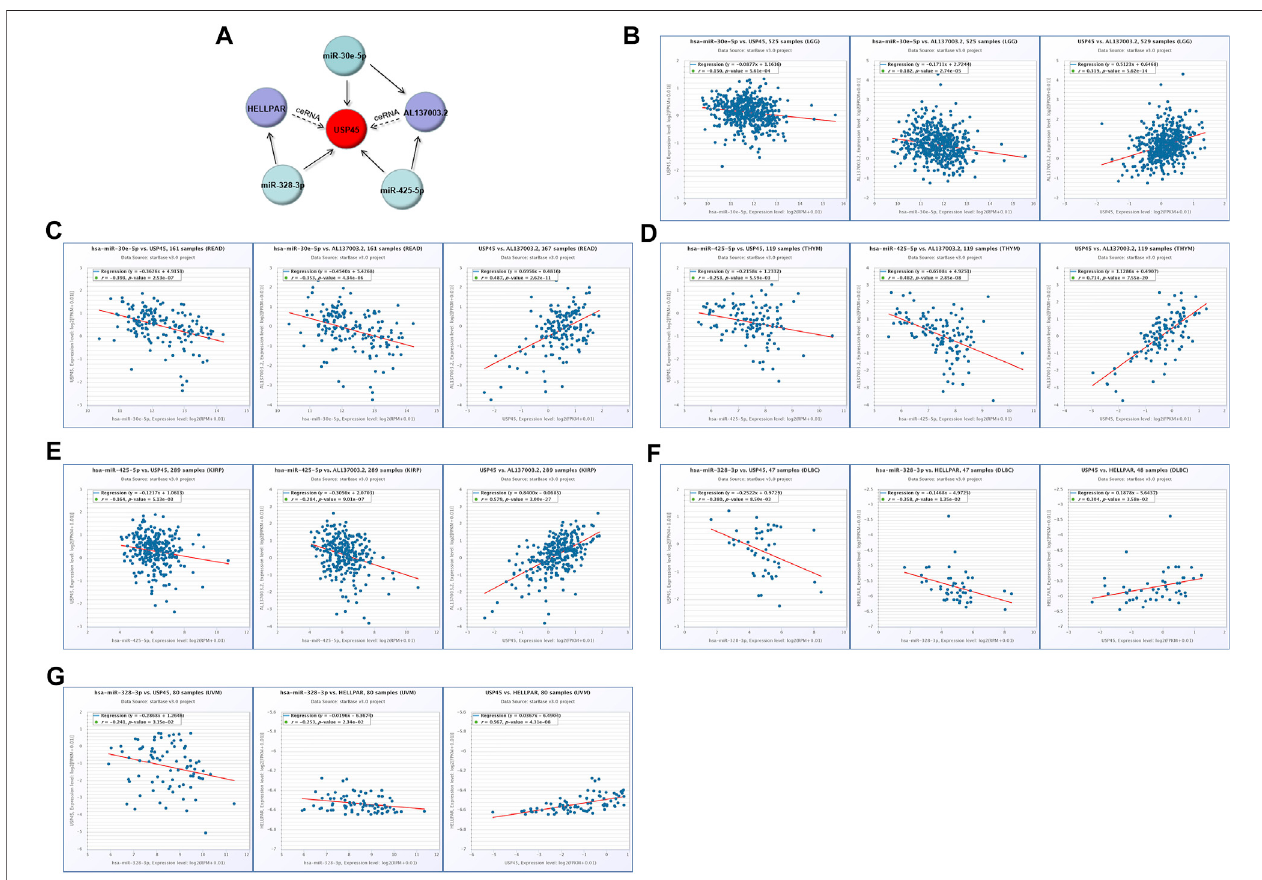
FIGURE8| ConstructionoftheceRNAnetworkforUSP45. (A) TheceRNAnetworkforUSP45wasanalyzedusingtheENCORIdatabase,andtheanalysisresults werevisualizedwithcytoscapesoftware.InLGG (B) andREAD (C) ,thecorrelationsamongUSP45,miR-30e-5pwithAL137003.2wereanalyzed.InTHYM (D) andKIRP (E) , thecorrelationamongUSP45,miR-425-5p withAL137003.2 wasanalyzed. In DLBC (F) and UVM (G) , thecorrelationsamong USP45,miR-328-3p withHELLPAR were analyzed.